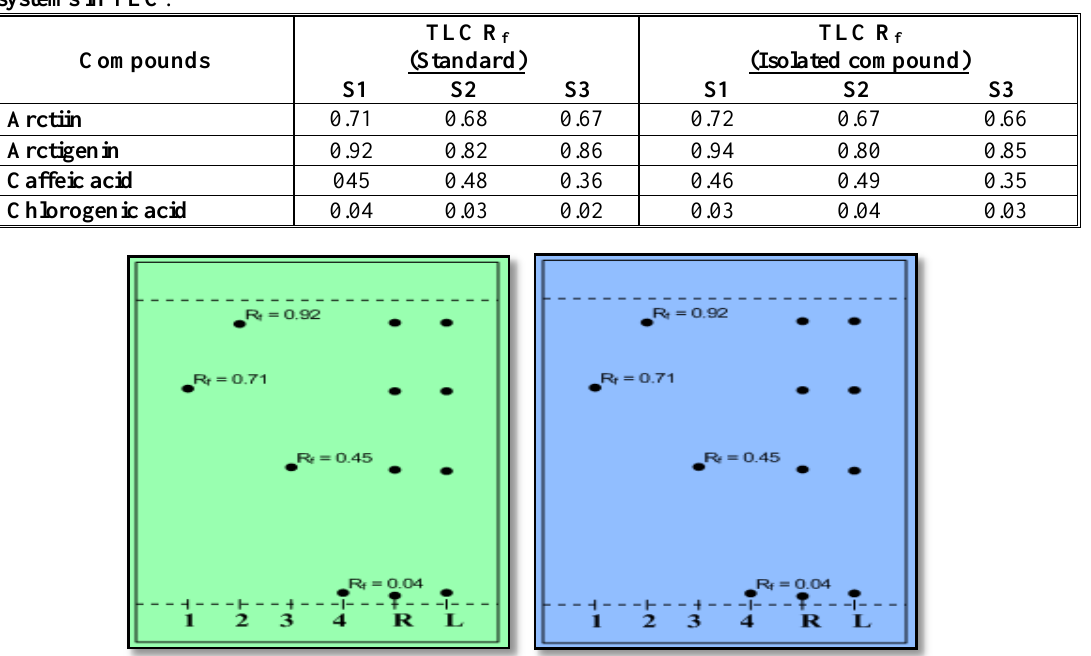
Figure 1 :Thin layer chromatograms of both root and leaf sample with four references standard on silica gel GF , developing in S1 solvent system and detection by UV light at 254 nm & 366 nm.[ 254 1:Std. Arctiin , 2: Std.Arctigenin , 3:Std. Caffeic acid , 4: Std.Chlorogenic, R: root extract, L: leaf